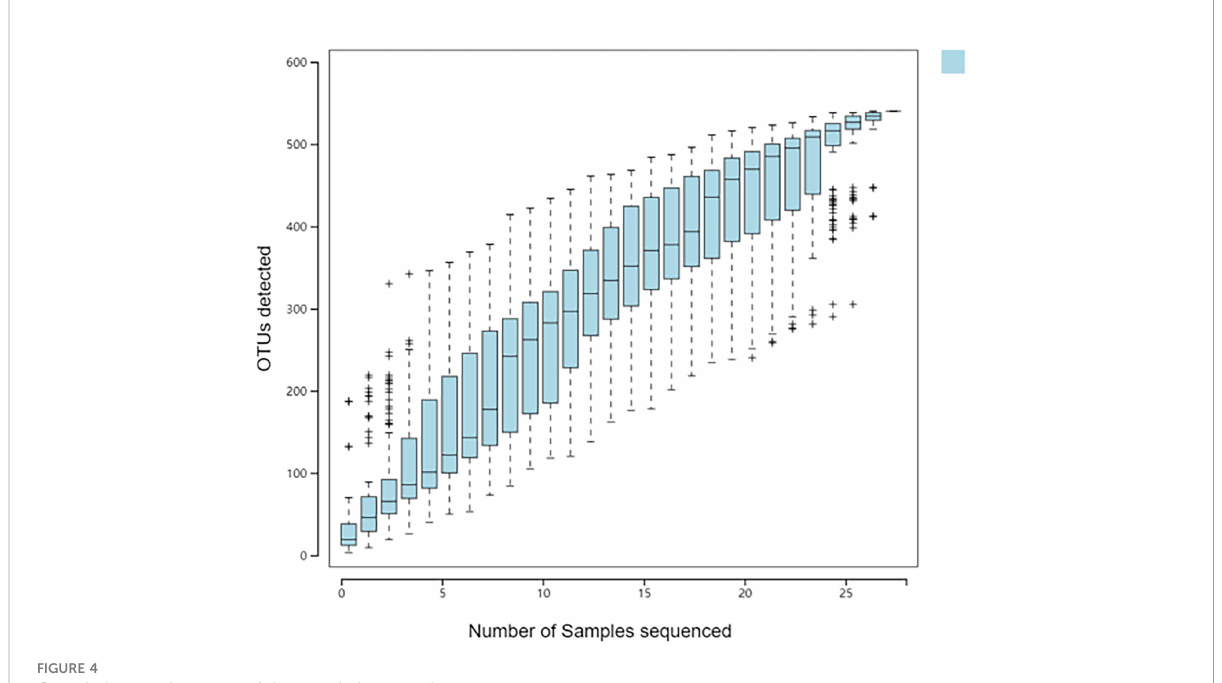
FIGURE 4 Cumulative species curve of the population